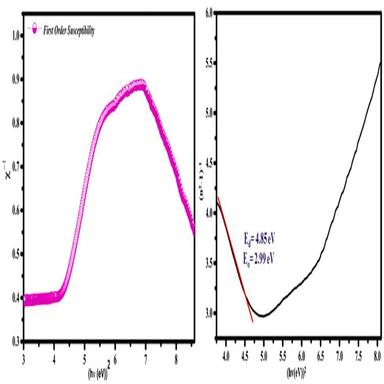
First susceptibility vs (hν) 2 and (n2 − 1) − 1 linear fitting of La2SrFe2TiO9.